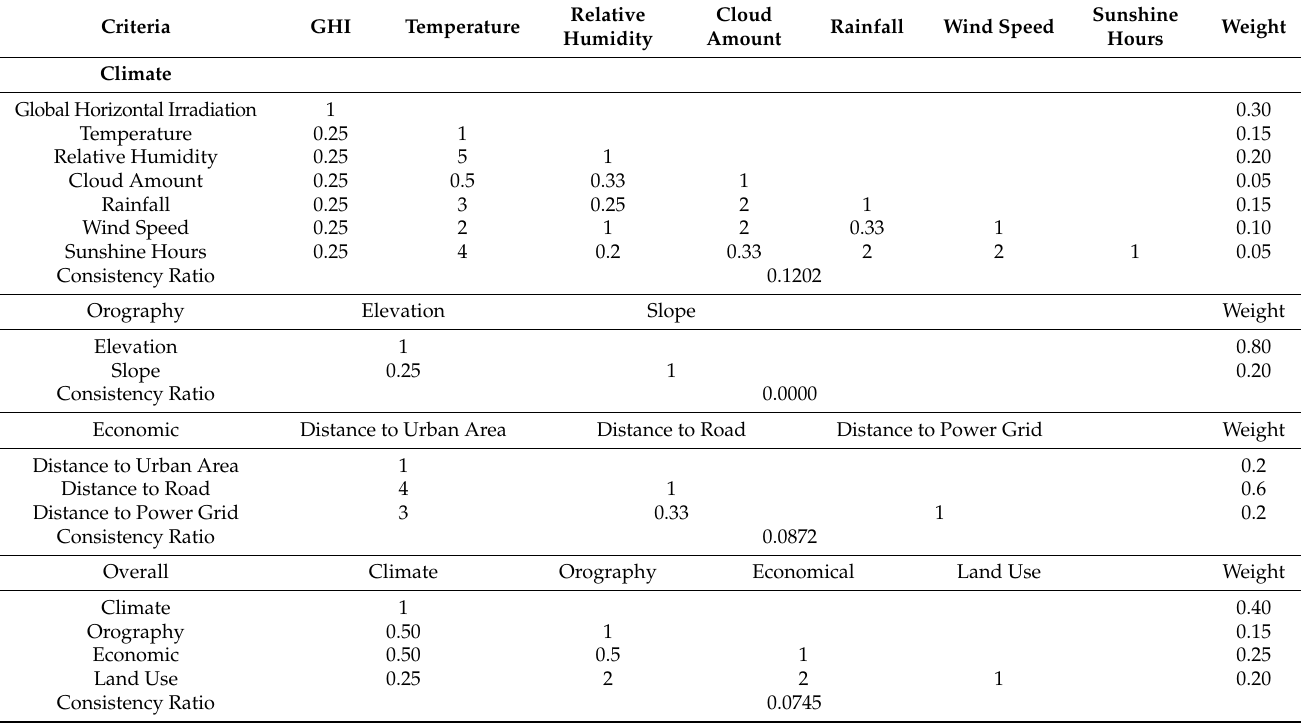
Table 8. Pairwise comparison